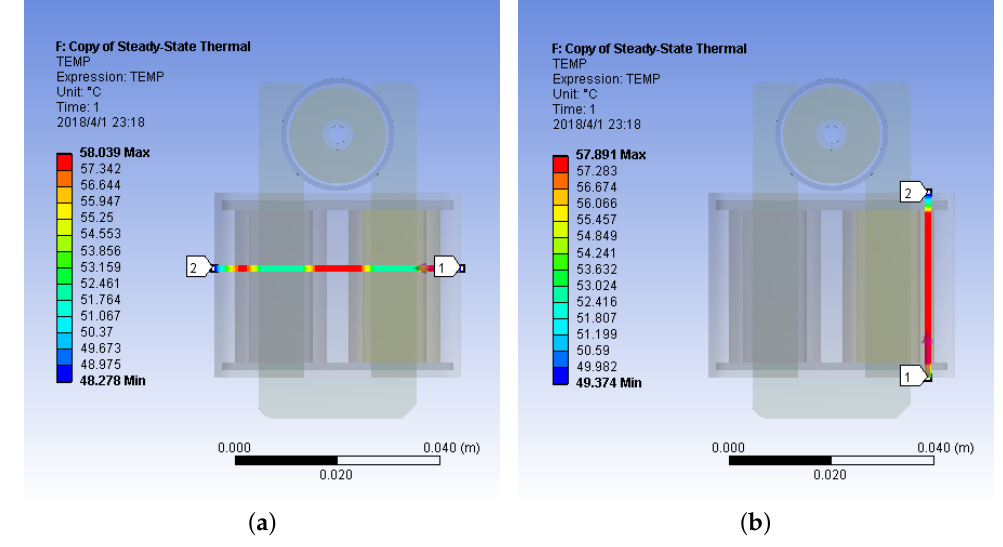
Figure 12. ( a ) Test spline in x direction. ( b ) Test spline in z direction.